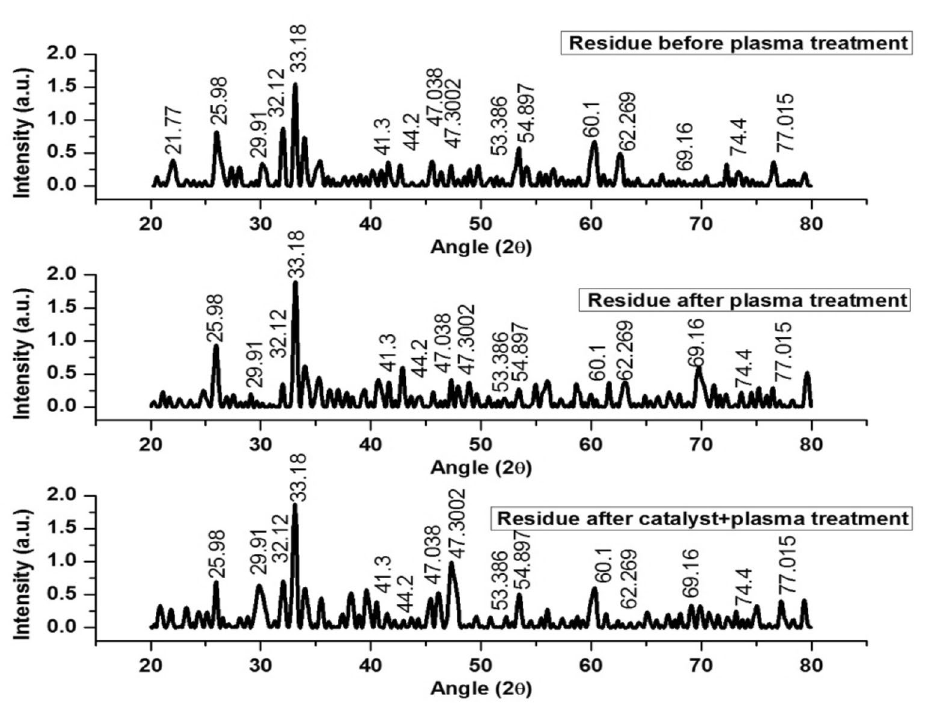
Figure 13. XRD profiles of solid residues of untreated and treated